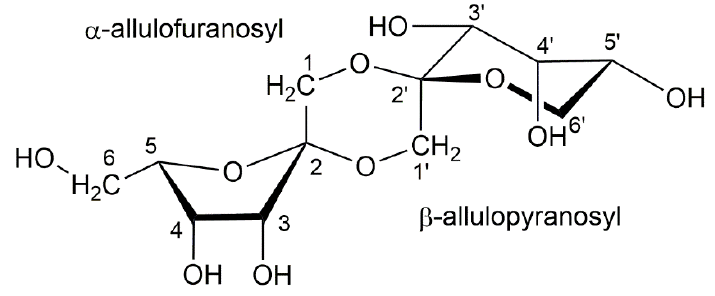
Figure 4. Molecular structure of di- D -psicose anhydride.